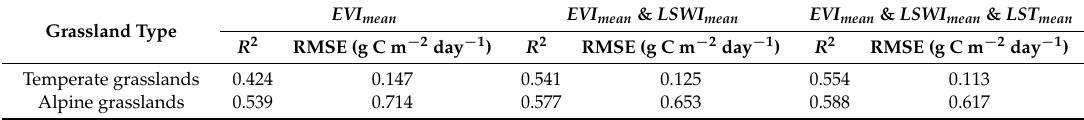
Table 4. Relationship between Reref and the combined effects of EVI mean , LST mean , and LSWI mean . Grassland